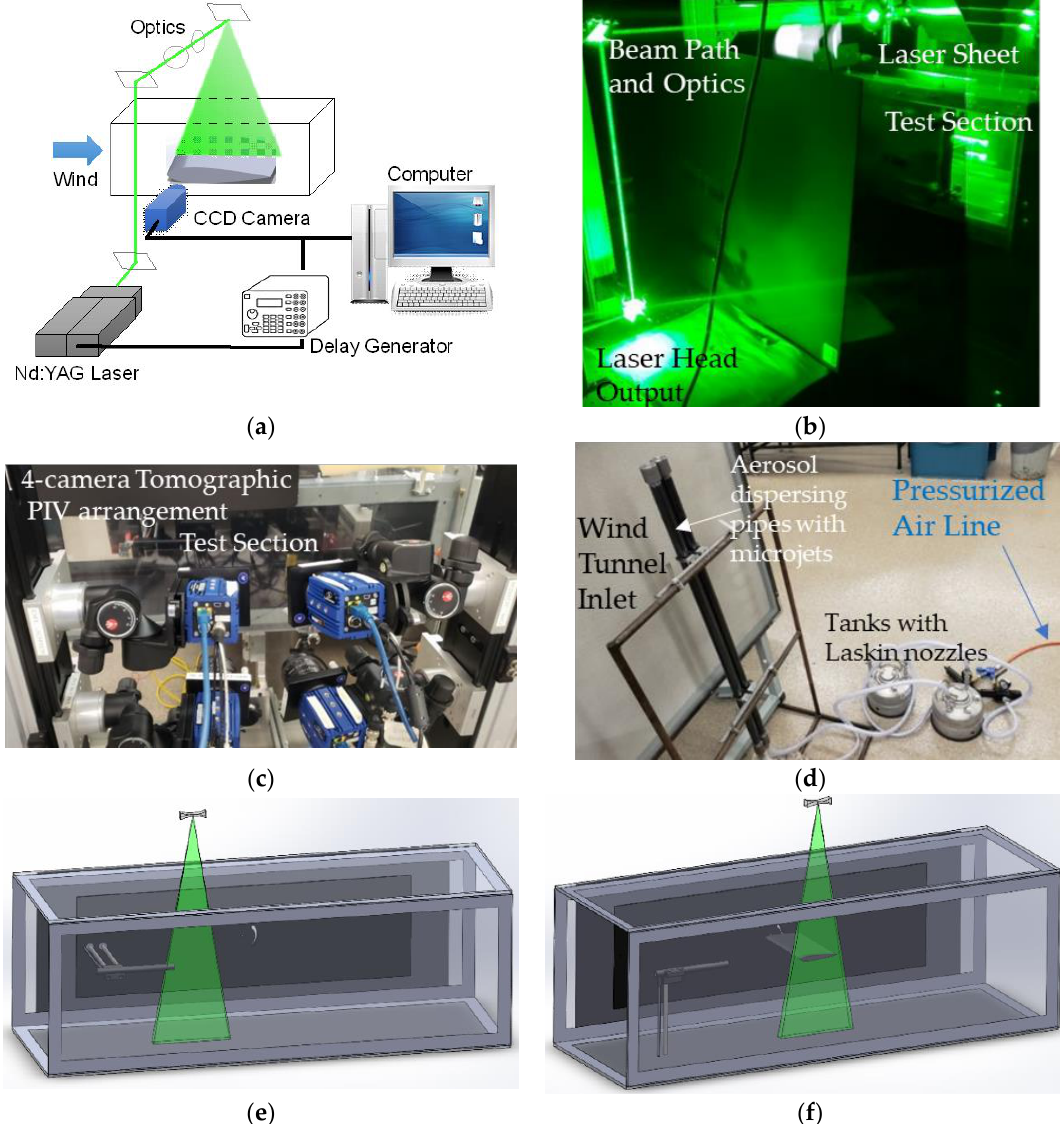
Figure 4. Schematic of standard particle image velocimetry (PIV) ( a ), photography of the laser beam path ( b ), the tomographic four-camera arrangement ( c ), and the particle seeding system components ( d ), and schematic of the laser illumination for the vortex tube ( e ) and airfoil ( f ) data acquisition campaigns.